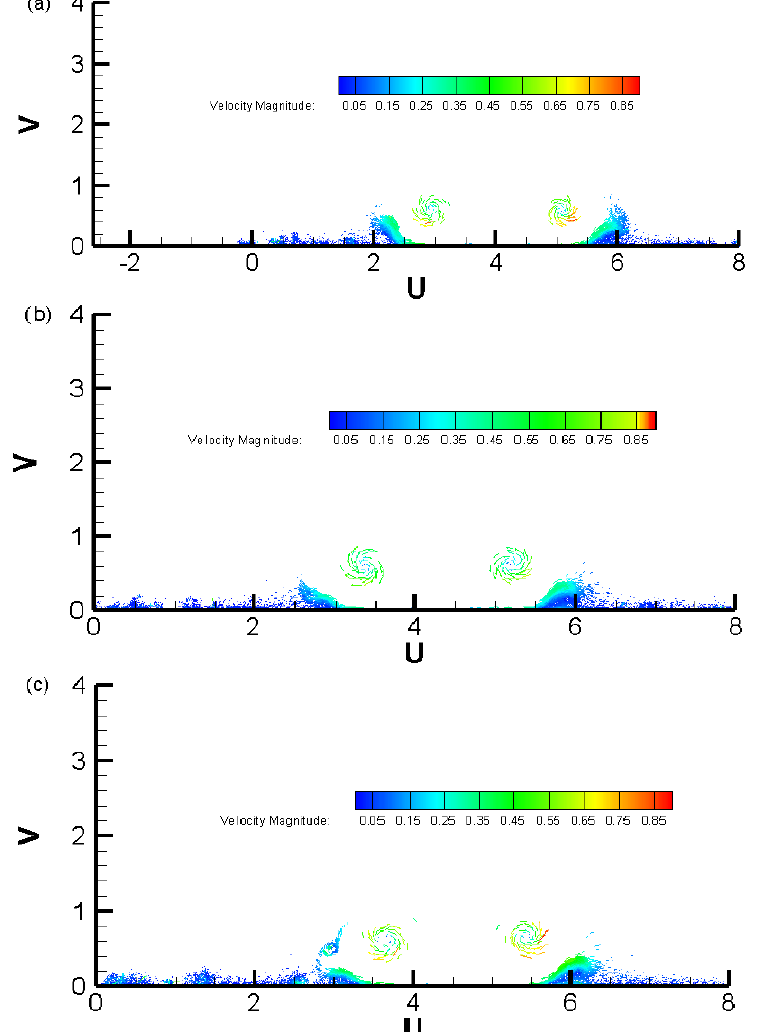
Figure 11. Instantaneous velocity field behaviors with combined effects of buoyancy and different crosswind magnitudes (Ri = 1.018, T ∞ * = 20 ◦ C, T W * = 40 ◦ C, Pr = 0.7, and Re = 7650): ( a ) t = 15.95 and U ∞ = 0.0; ( b ) t = 14.25 and U ∞ = 0.02; and ( c ) t = 13.95 and U ∞ = 0.04.